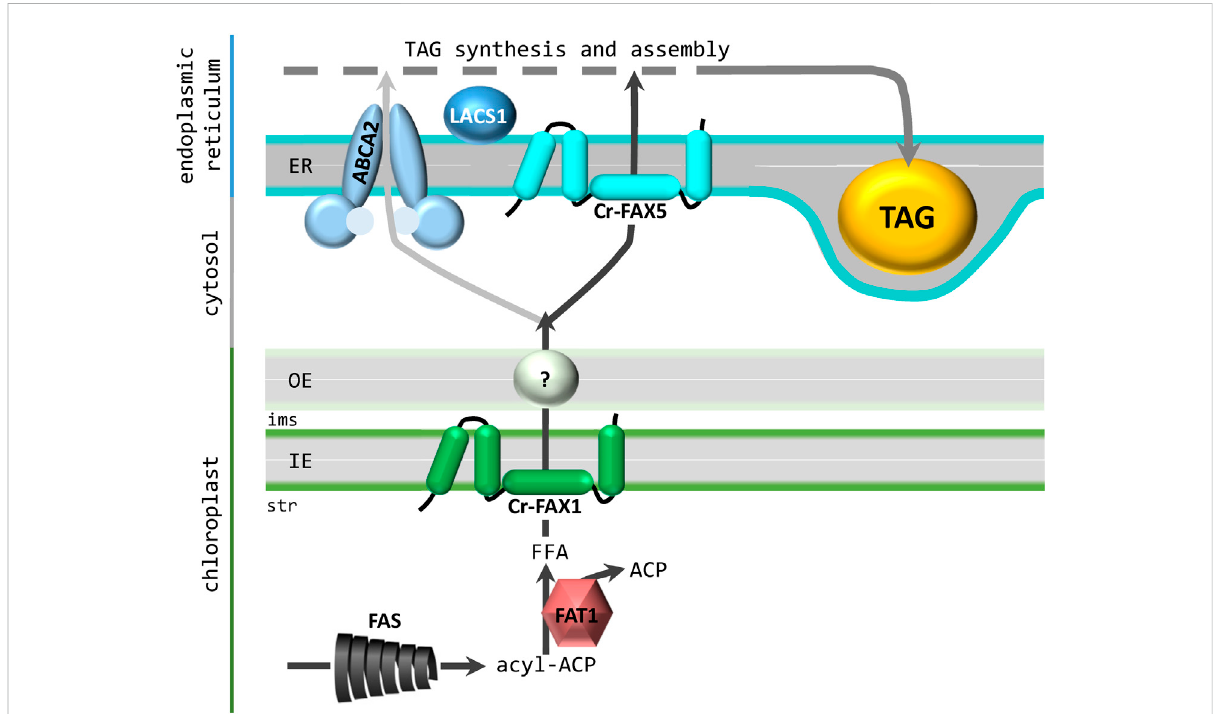
FIGURE 7 Contribution of Cr-FAX1 and Cr-FAX5 for oil synthesis in Chlamydomonas. According to our working hypothesis, Cr-FAX1 with its 4 α -helical domains (green) integrates in an asymmetric fashion into the inner envelope (IE) membrane of chloroplasts. Most likely the N-terminus is in the stroma (str) and the C-terminus in the intermembrane space (ims). In comparison to proteolytic pattern of Ps-FAX1 in puri fi ed IE membrane vesicles from pea chloroplasts (JP and KP, unpublished results), Cr-FAX1 presumably orients with the N-terminus to the stroma and the C-terminus exposed to the ims. Upon proteolysis of this C-terminus of Ps-FAX1, intermediate bands can be detected by an antiserum directed against an N- terminal peptide stretch (JP and KP, unpublished results). Since the C-terminus of the structural model shown in Figure 2C is almost completely protected by the lipid bilayer, the model of Figure 2B, which is adapted here, is more likely to lead to these intermediate band pattern. Cr-FAX5 (turquoise) in a similar fashion sits in the membrane of the endoplasmic reticulum (ER). De novo fatty acid synthesis (FAS) occurs in the chloroplast stroma and the acyl-ACP thioesterase 1 (FAT1) generates free fatty acids (FFA) for export mediated by FAX1. The transport mode for FAs across the outerenvelope(OE)membranestillisunclear.ImportofFFAsand/oracyl-CoAintotheERoccursviatheABCtransporterABCA2andwiththehelpof FAX5. If both proteins act together or represent different FA import routes remains to be elucidated. However, function of ABCA2 and FAX5, most